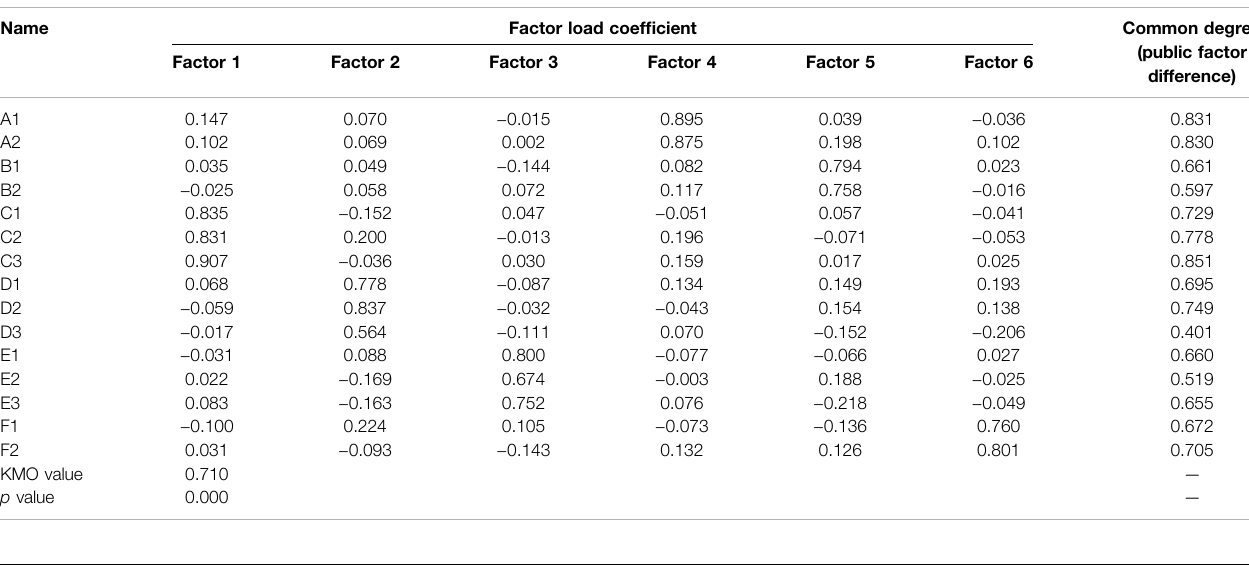
TABLE 3 | Results of effectiveness analysis.